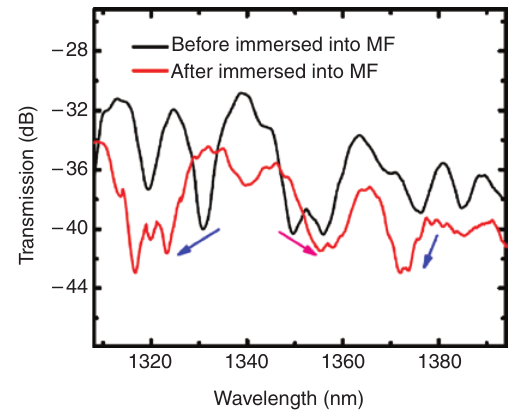
Figure 3: Transmission spectra of the all-solid WAF with five peri- odic microtapers before and after being immersed into the MF.